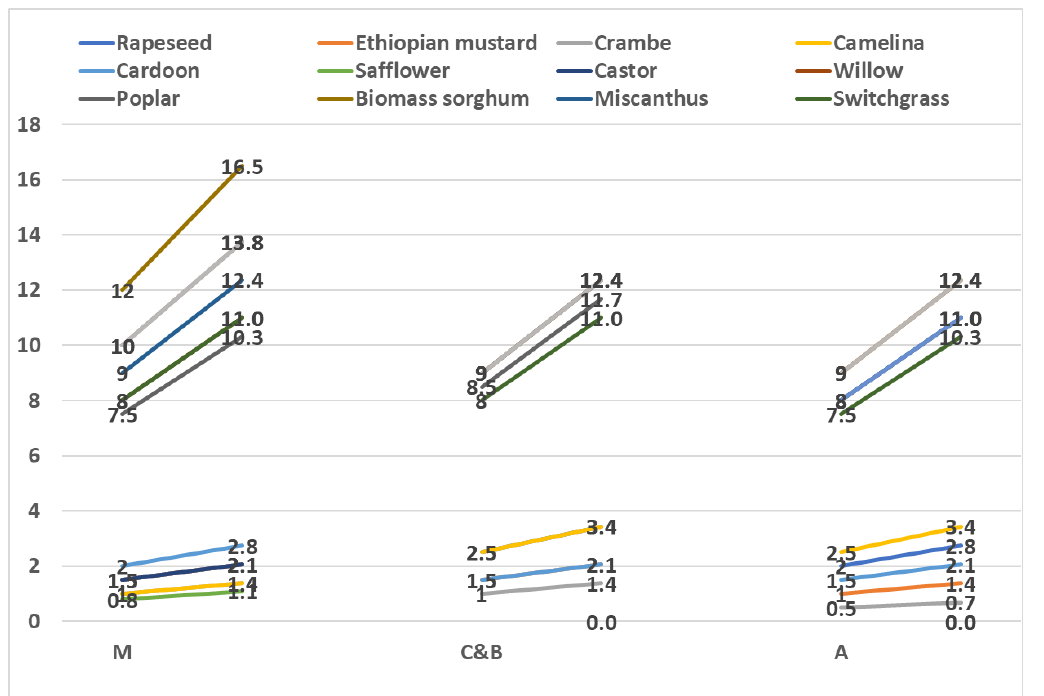
Figure 3. Estimated yield increases from the sustainable agricultural practices in land with natural constraints in the three AEZ [16,17]. Details in Annex I (Tables A1 and A2).